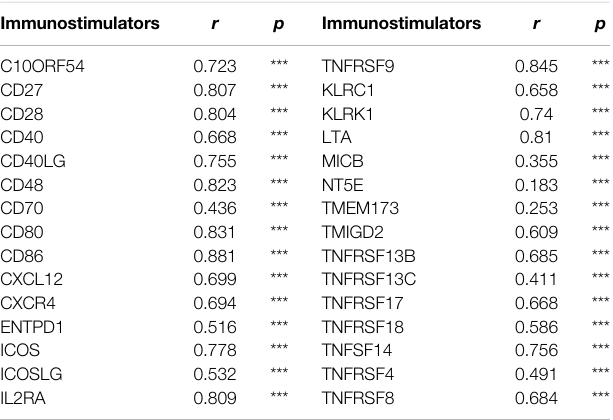
TABLE 3 | The correlation analysis between RETSAT and the expressions of immunoinhibitors in SKCM validated by TIMER database.